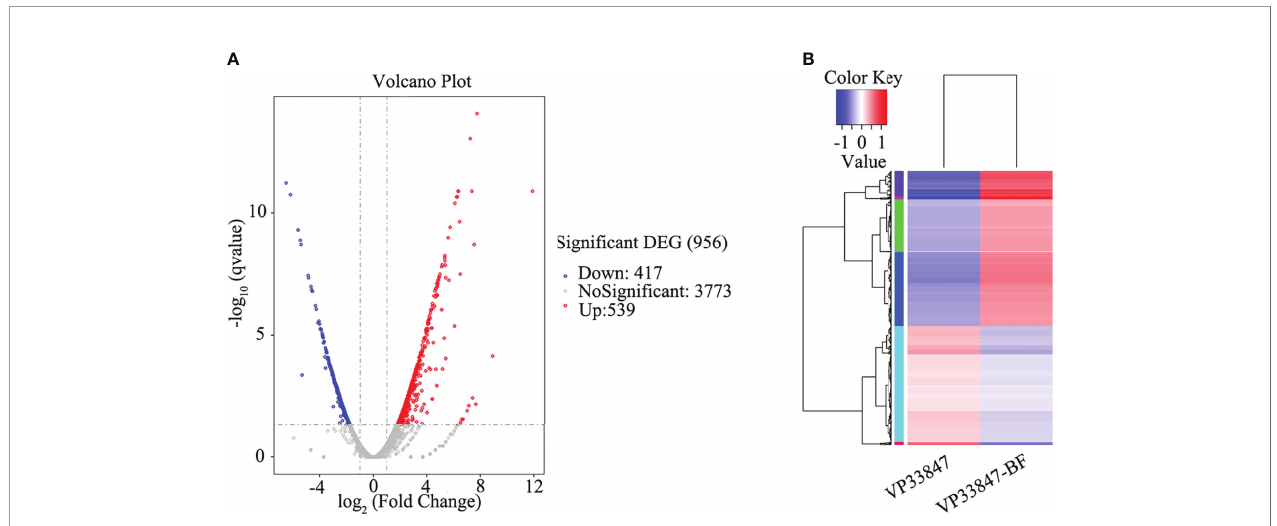
FIGURE 7 | Differential expression analysis of experimental comparison group. (A) volcano plot. (B) hierarchical clustering plot.